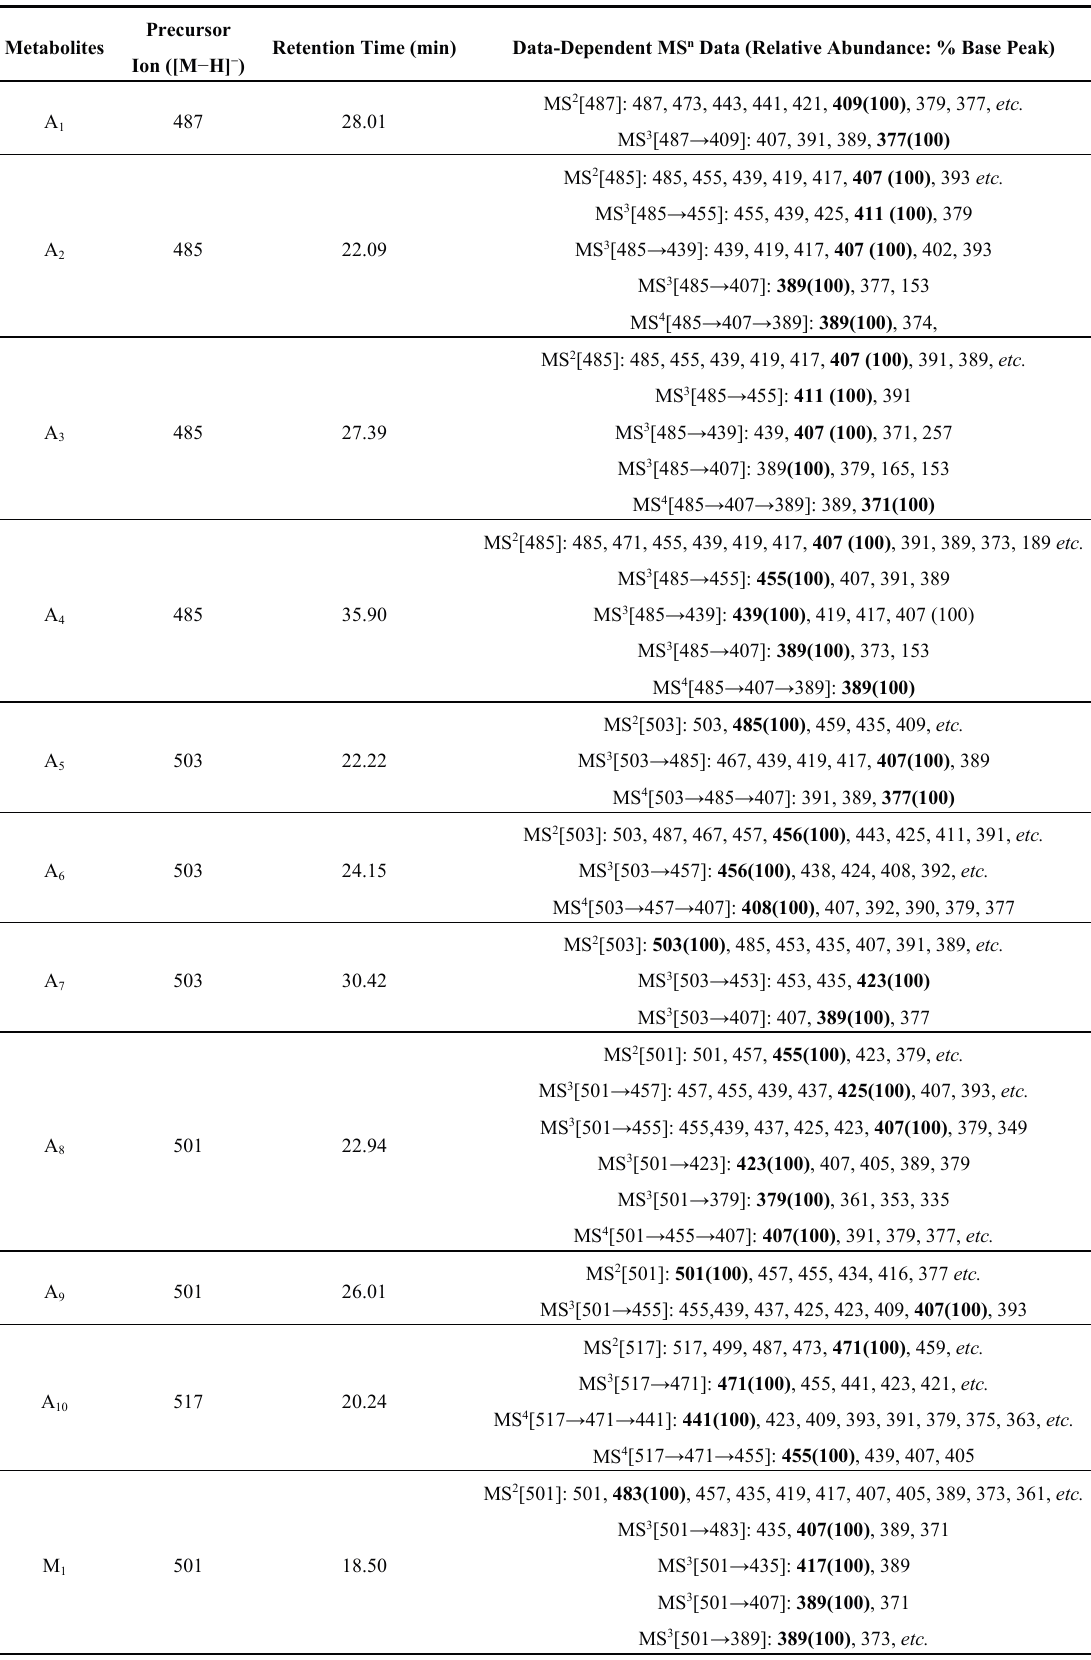
Table 2. Chromatographic retention times, mass spectrometric data of potential metabolites of AA (A 1 –A 10 ) and MA (M 1 –M 9